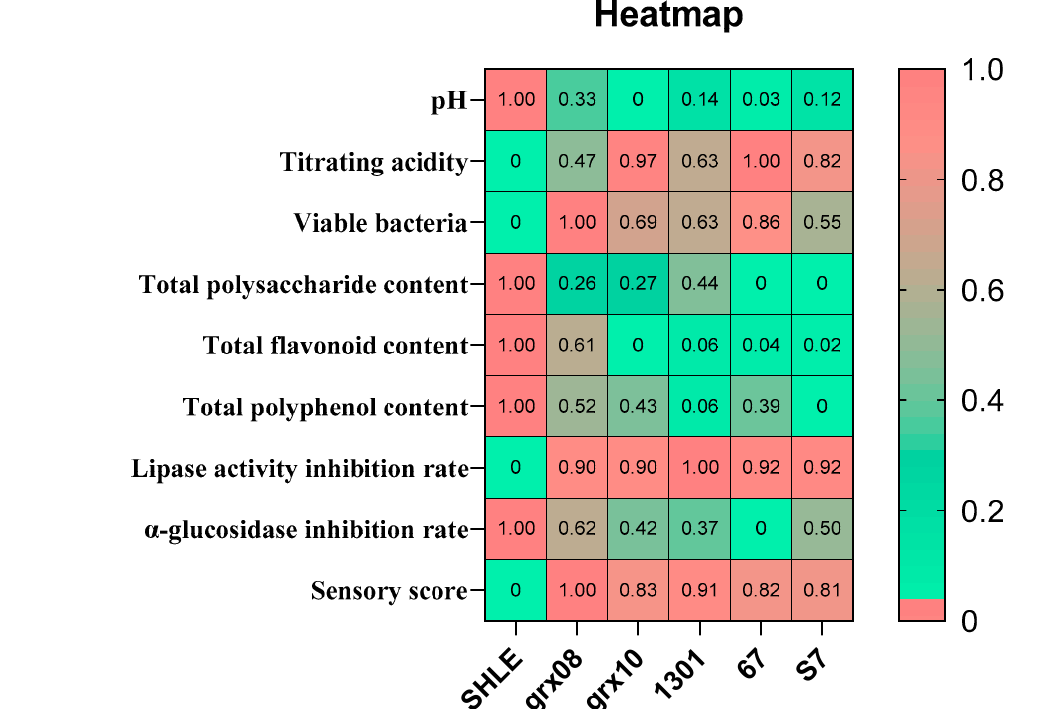
Figure 5. Effects of fermentation with different lactic acid bacteria on SHLE flavor. ( A ) Sensory scor- ing radar chart and ( B ) total score of sensory evaluation. Values are expressed as the mean ± stand- ard deviation of replicate experiments ( n = 10). Different letters indicate a significant difference ( p < 0.05).